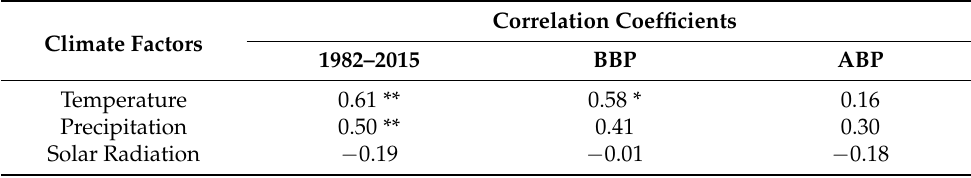
Table 1. Correlation between NDVI and climate factors.